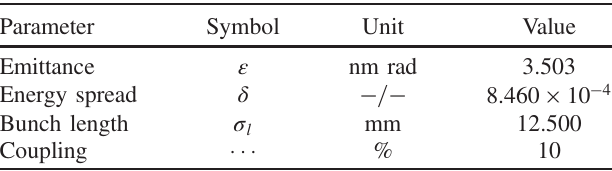
TABLE VII. Main parameters of the injected beam.